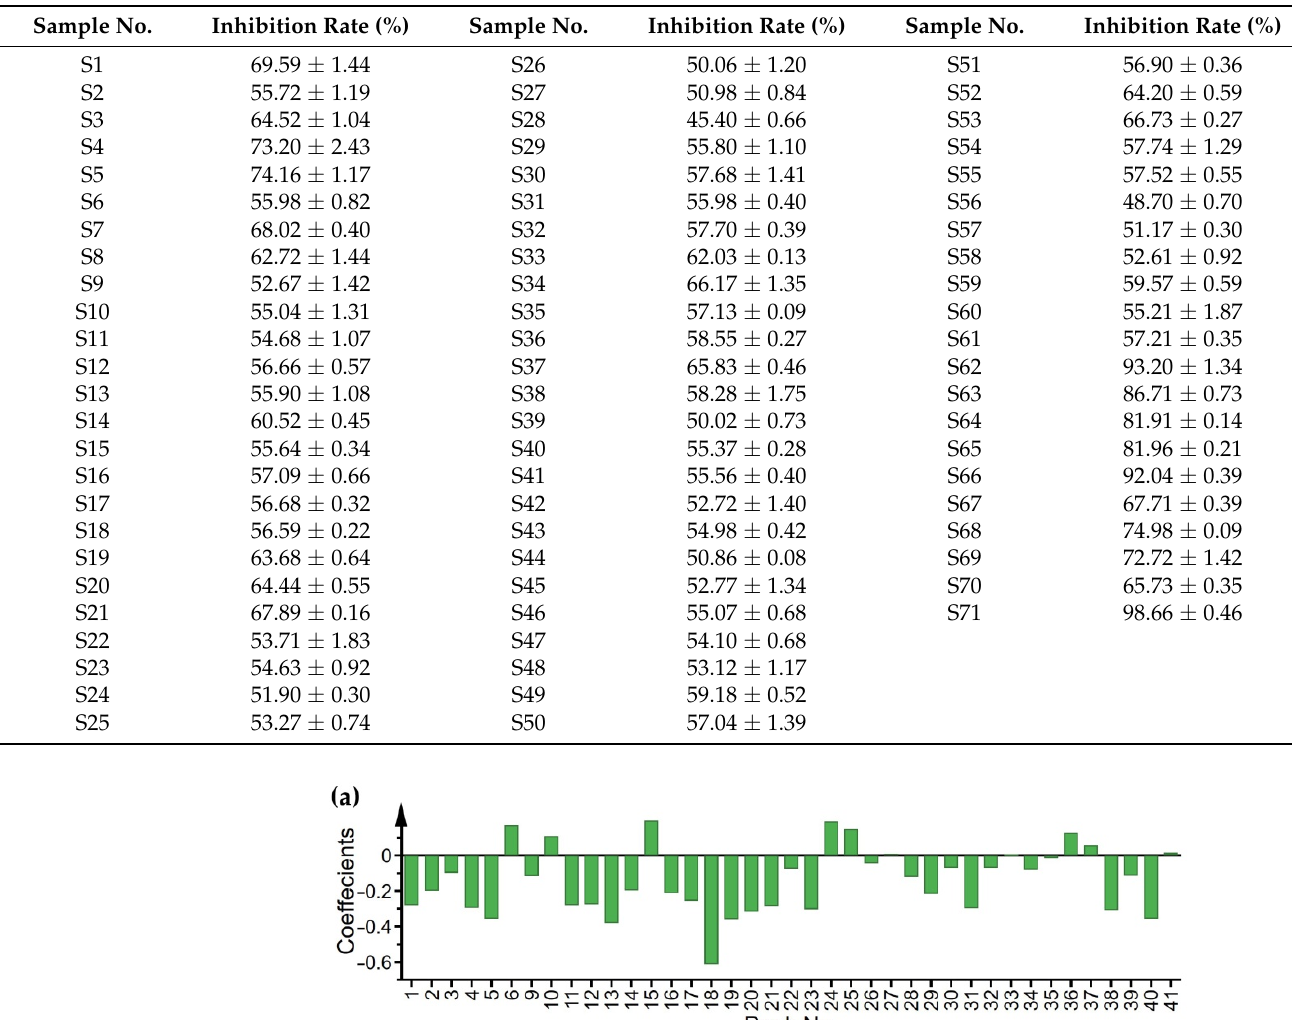
Table 1. The inhibition rates of 71 batches of LJF samples.